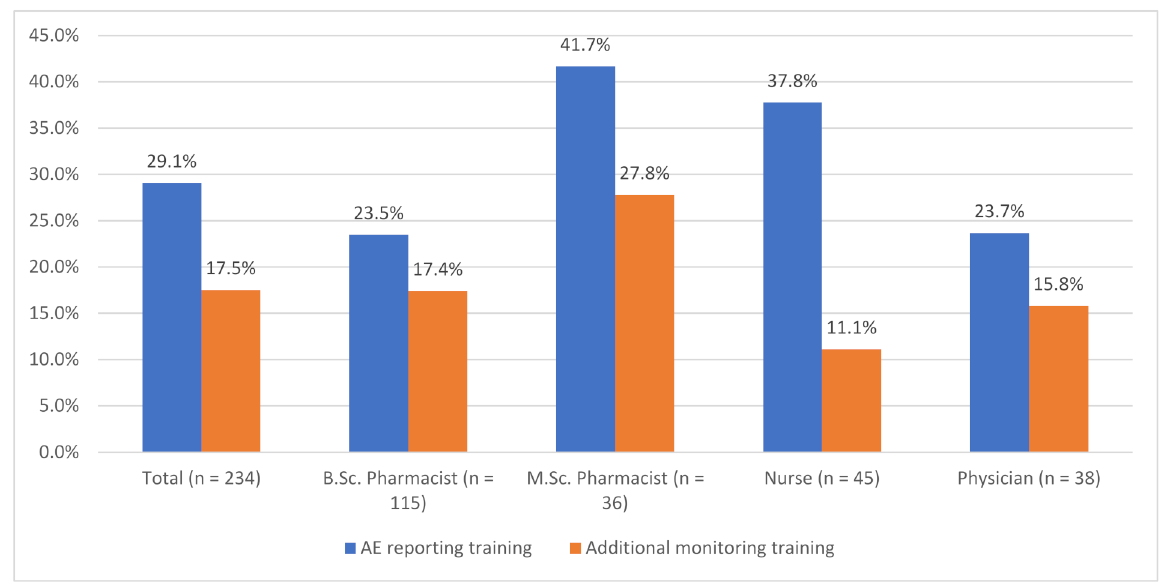
Figure 2. Percentage of healthcare professionals who have received pharmacovigilance